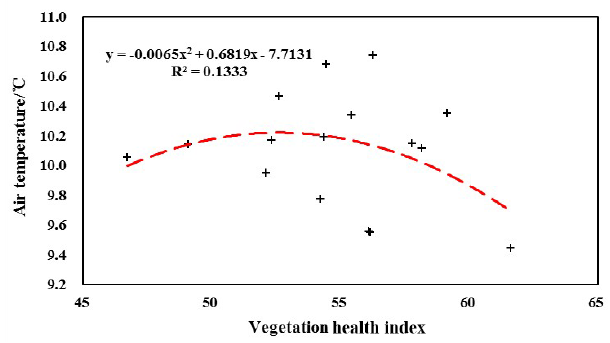
Figure 12. Correlationship between air temperature and the VHI during 2000–2015 in the Wei River